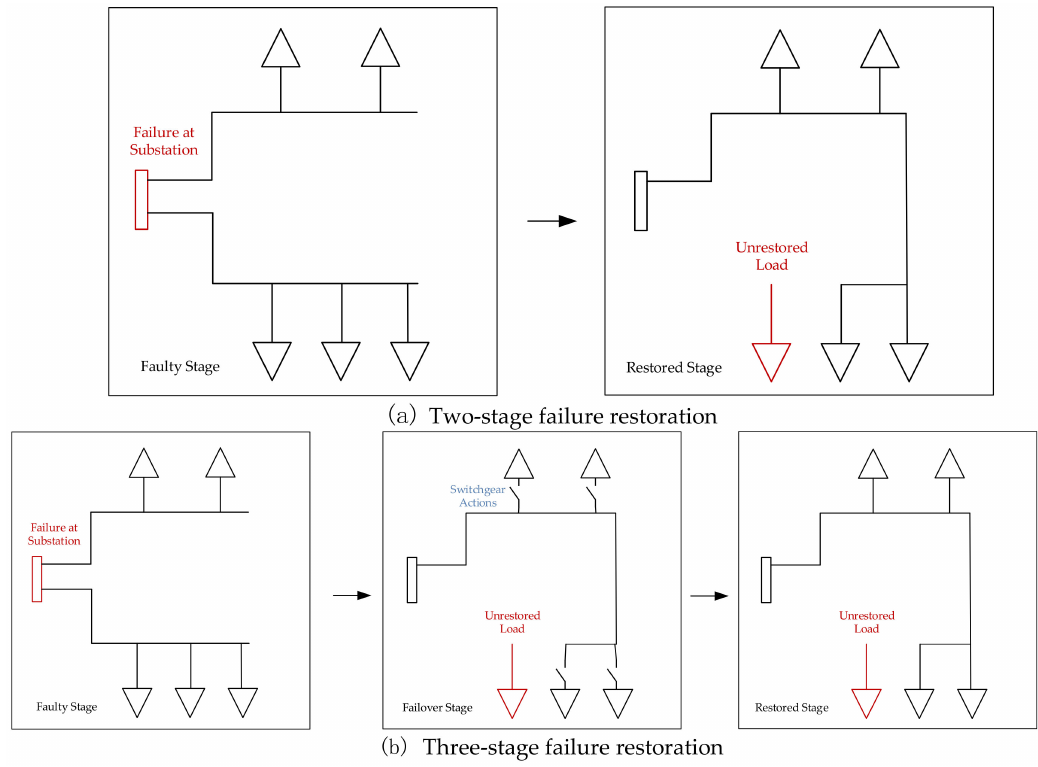
Figure 1. Failure restoration process after natural